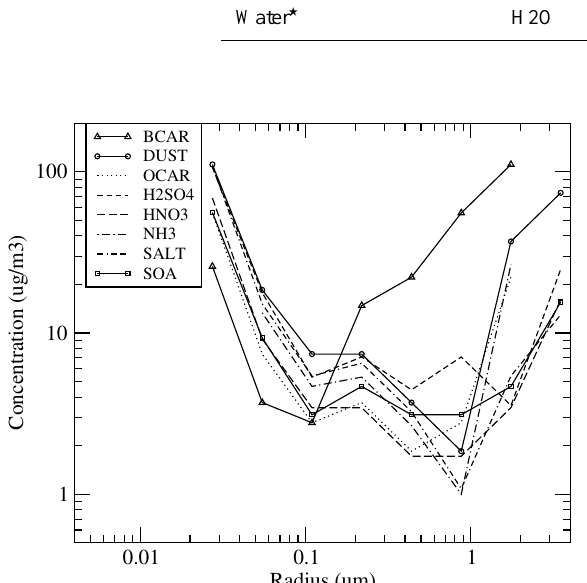
Fig. 7. Differences in the simulated attenuated scattering ratio (left) and color ratio (right) per size section as a function of the multiple scattering parameter η 0 .